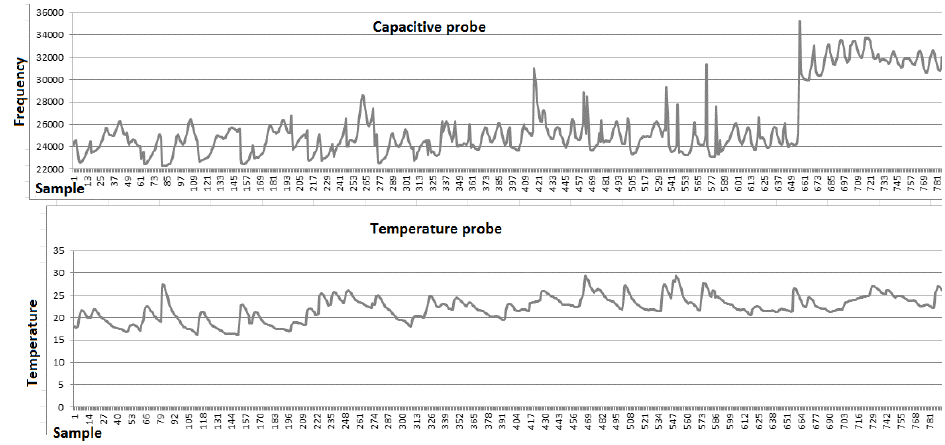
Figure 18. Temperature influence in a real production test.